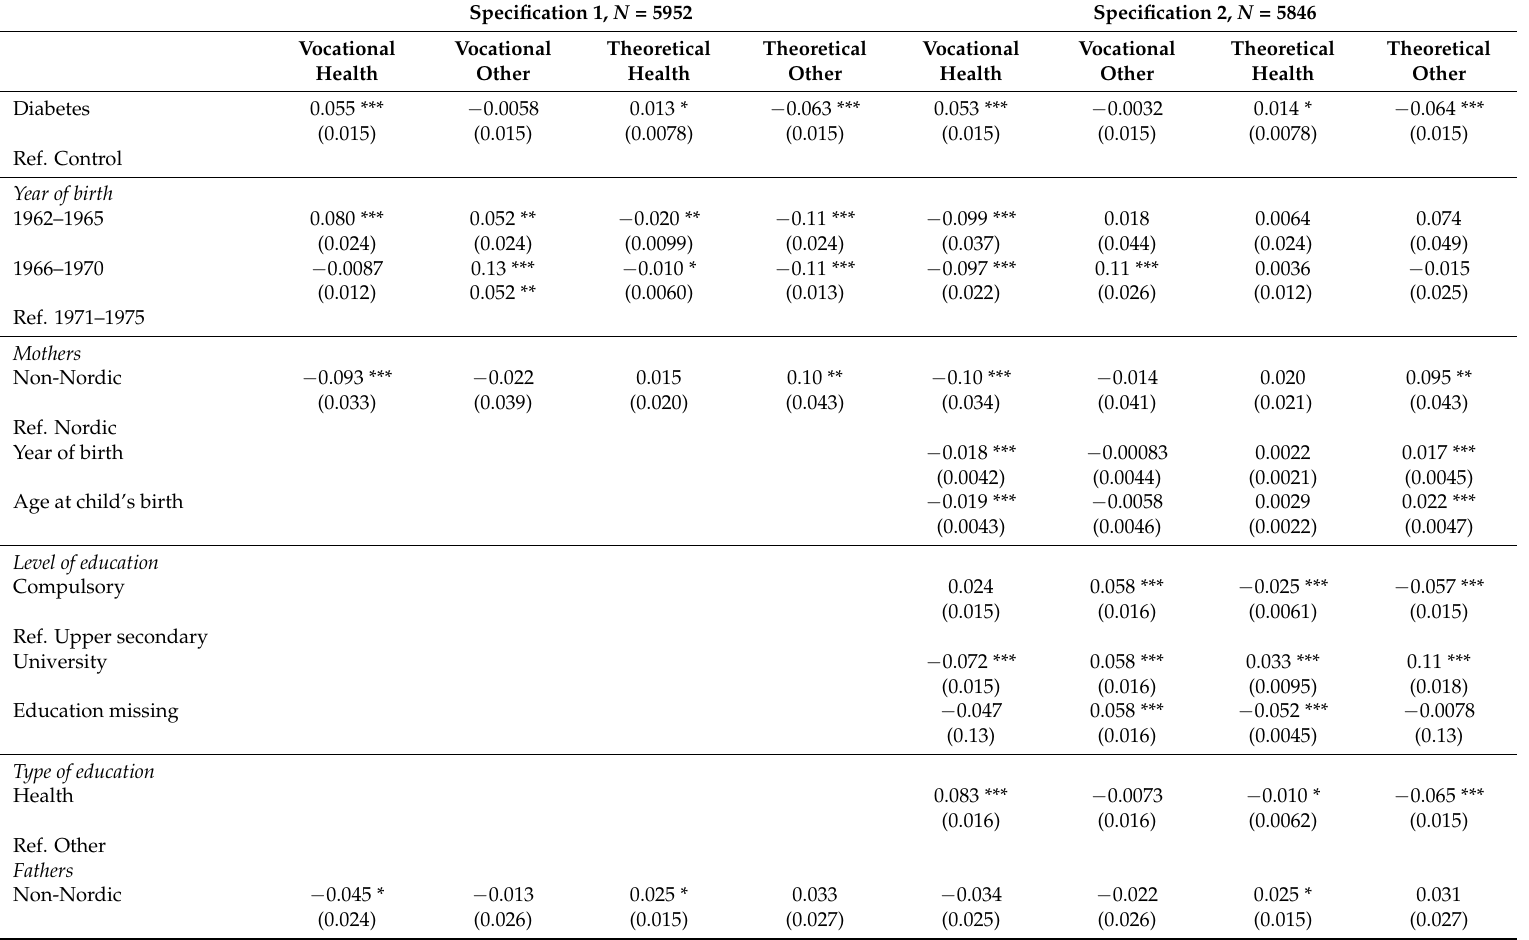
Table 3. Average marginal effects of women’s probability of having different fields of upper secondary